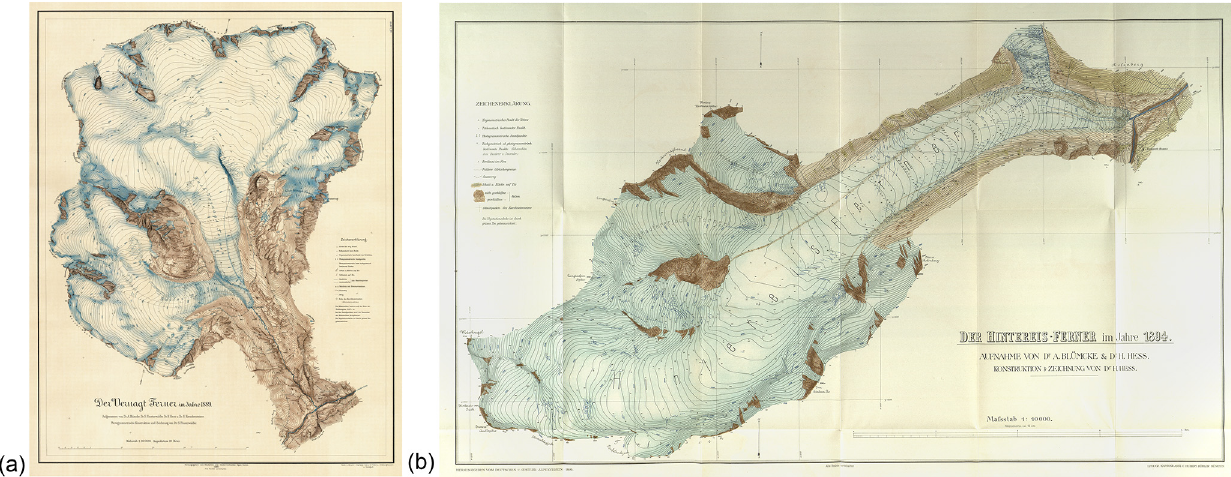
Figure 2. (a) The 1889 map of Vernagtferner showing the entire glacier in large scale: “Der Vernagtferner im Jahre 1889 1:10000” (Fin- sterwalder, 1897). (b) “Der Hintereisferner im Jahre 1894” (Blümcke and Hess,